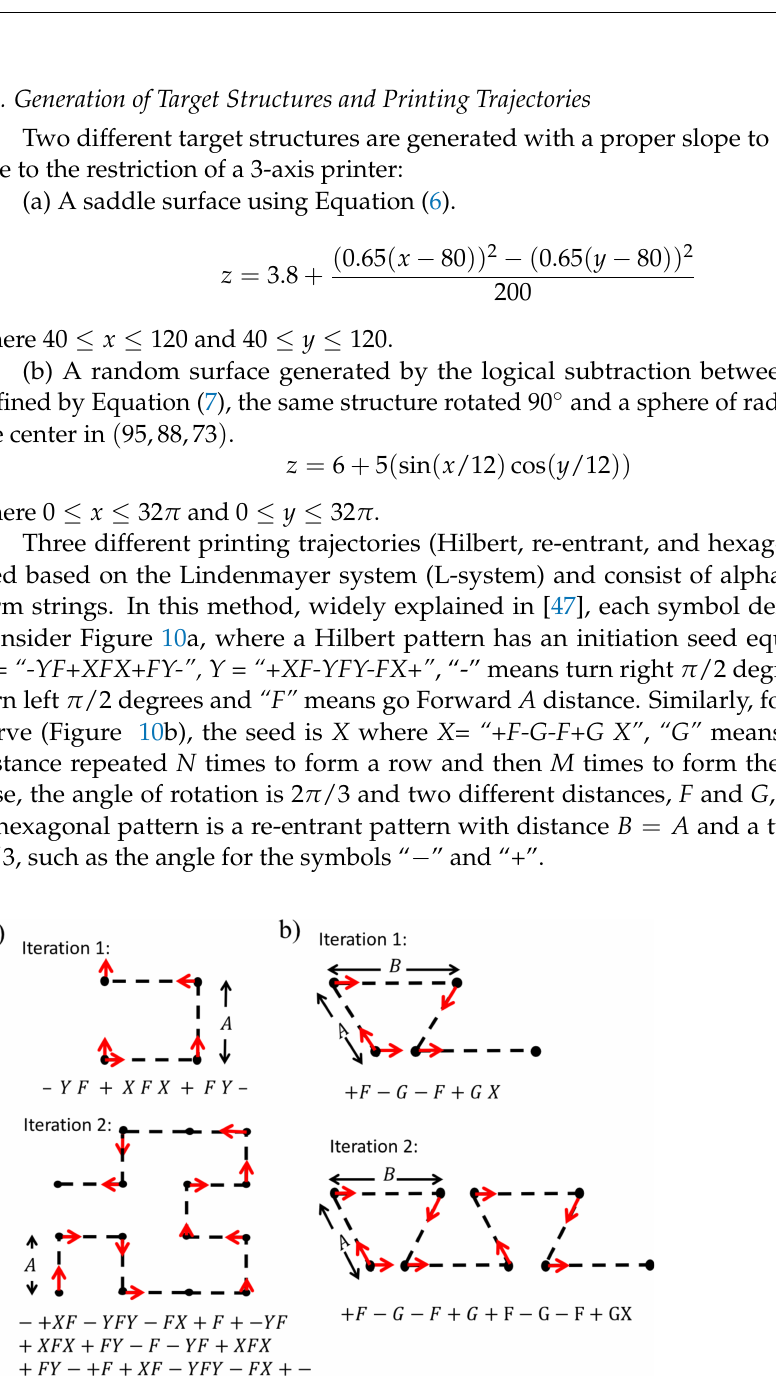
The first and second iterations are based on the L-system for ( a ) Hilbert and ( b ) re-entrant